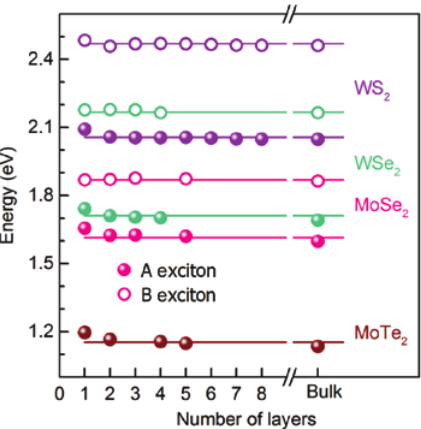
Figure 5: Energies of A and B exciton resonances as a function of number of layers, in different S-TMD multilayers, as determined from the absorption type (reflectance contrast)